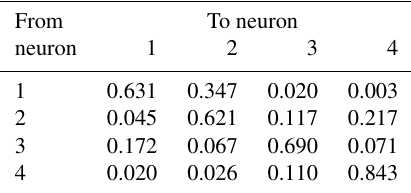
Table 1. Transition probabilities among neurons. From To neuron